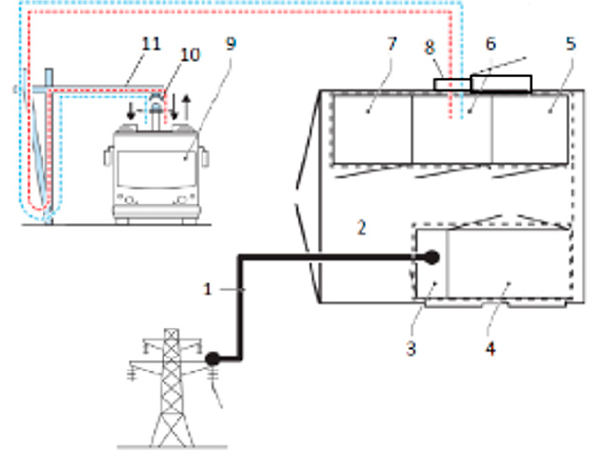
Figure 1. Heliox charger system overview. 1: AC grid connection, 2: Container, 3: AC income cabinet,